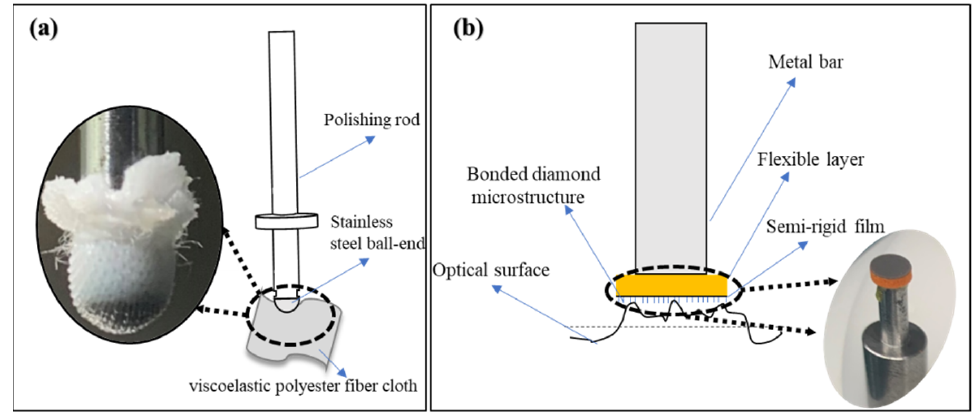
Figure 8. ( a ) Small spherical polishing tool structure; ( b ) Semi-flexible small polishing disc tool structure.